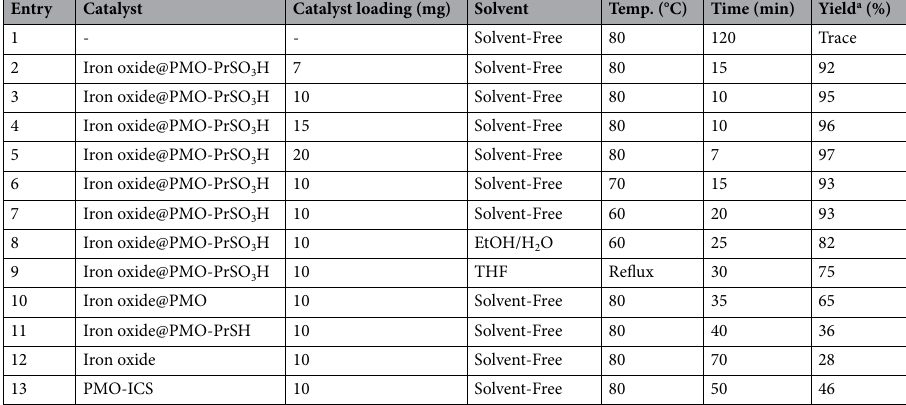
Table 1. Optimization of the conditions for the model reaction in the synthesis of imidazopyrimidine derivative 6a.